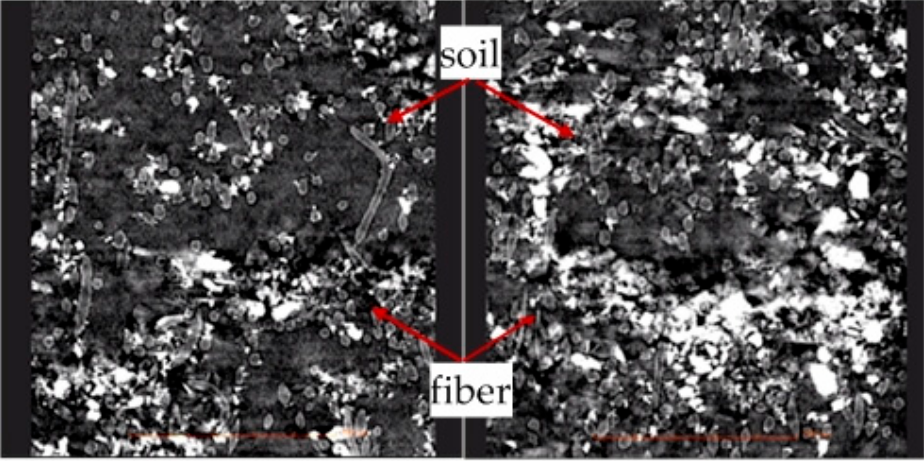
Figure 13. Nonwoven geotextile B after the cyclic water flow test.